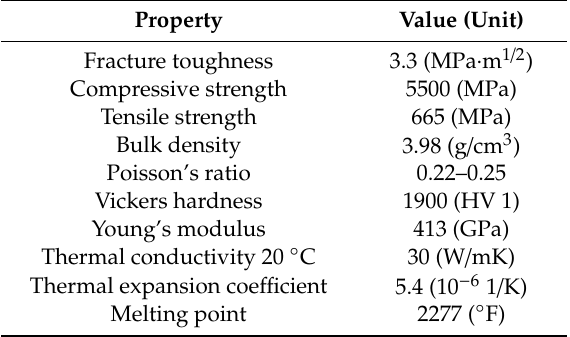
Table 1. Mechanical and thermal properties of biolox